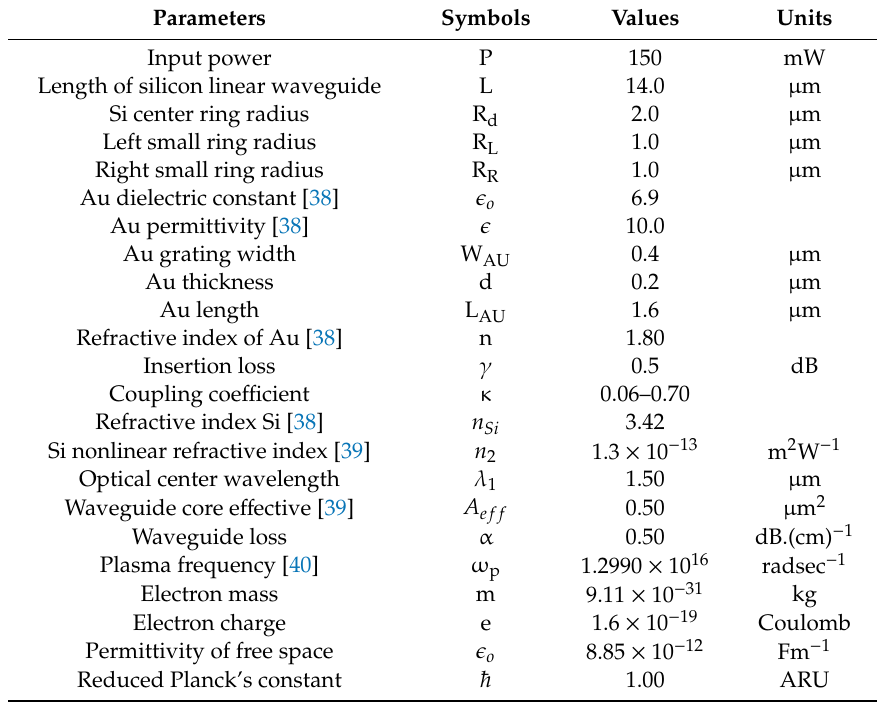
Table 1. The selected simulation